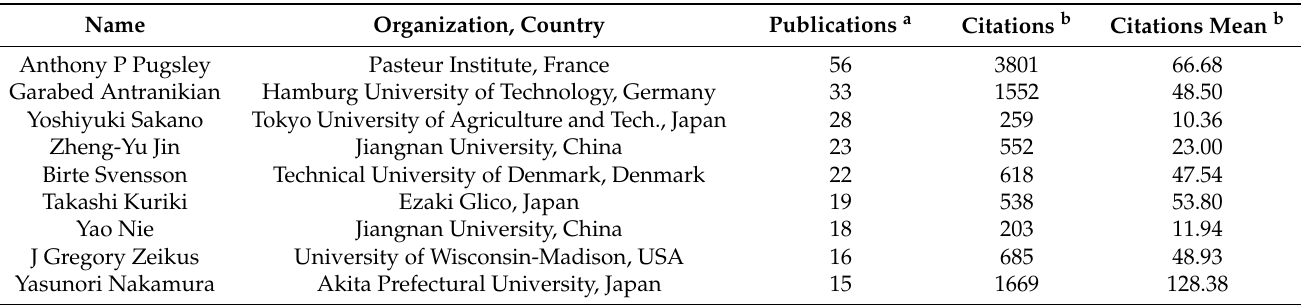
Table 2. Prominent authors that have published more than 15 documents related to pullulan- degrading enzymes.